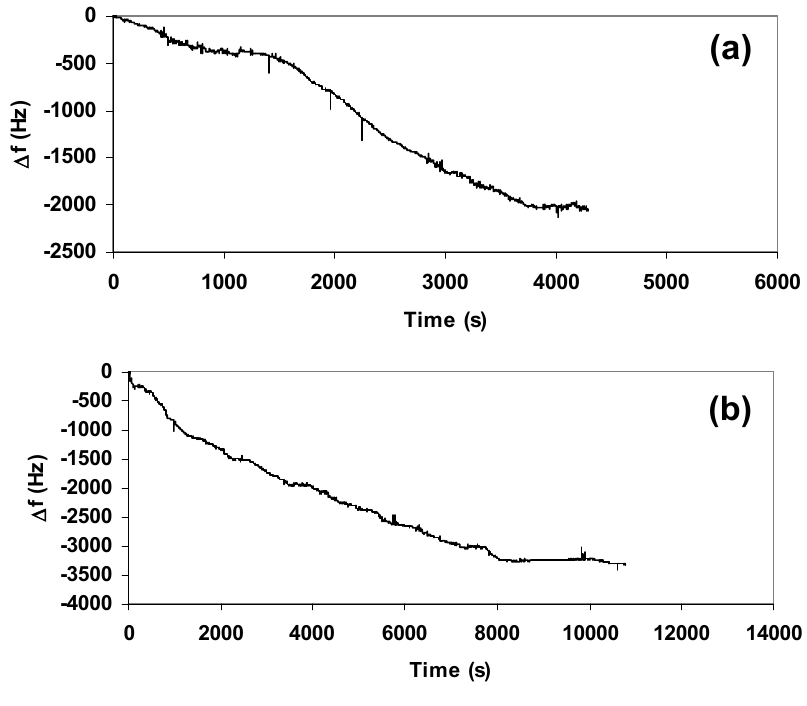
Figure 4. Variation of frequency due to carbonation of CaO obtained from different blown into the atmosphere-controlled chamber: ( a ) 250 mg; ( b ) 450 mg; quantities of CO 2 ( c ) 650 mg.